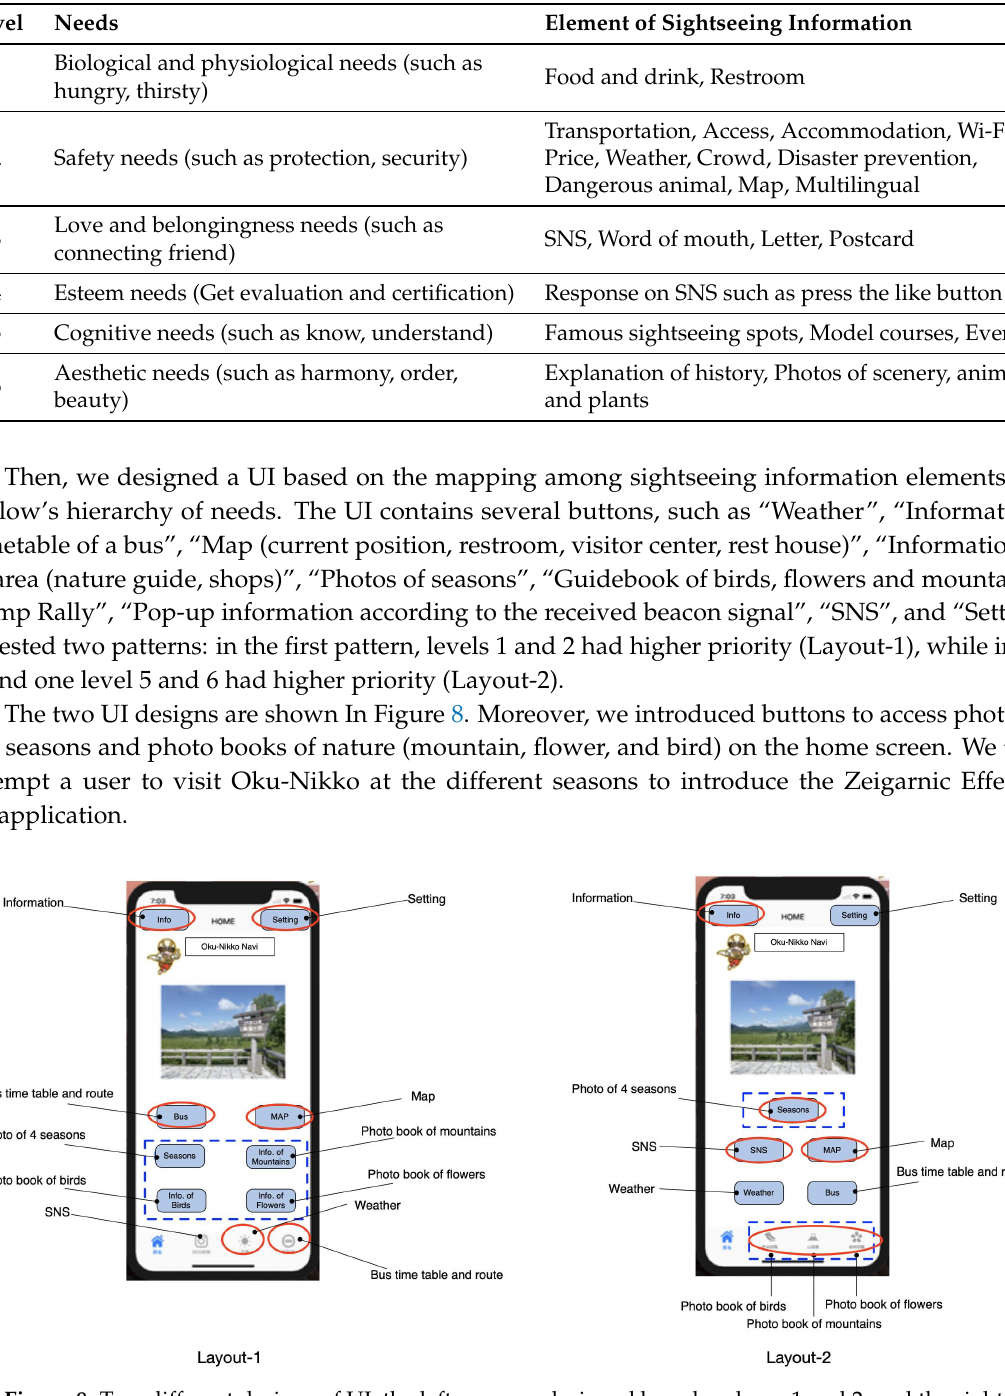
Figure 8. Two different designs of UI: the left one was designed based on layer 1 and 2, and the right one was designed based on layer 5 and